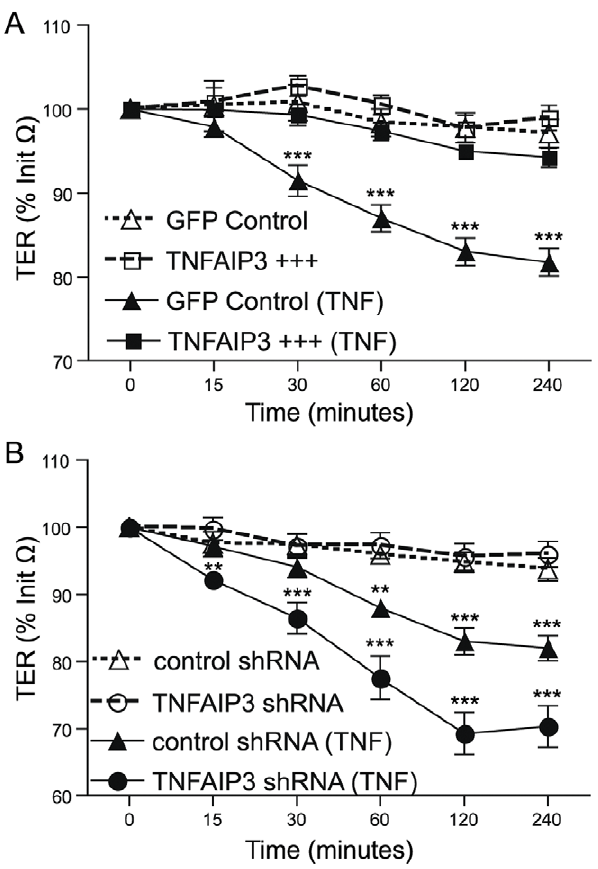
Figure 5. TNFAIP3 regulates TNF-induced tight junction dynamics in intestinal epithelial cells. Transepithelial electrical resistance (TER) was measured serially in cells grown in semi-permeable supports untreated (open symbols) or treated with TNF (10 ng/ml; closed symbols) for the indicated times. Values represent percentage of initial resistance measurements (% Init V ). Pools of cells were stably transduced with (A) GFP alone (GFP control; triangles) or GFP and TNFAIP3 (TNFAIP3 +++ ; squares); or (B) scrambled shRNA (control shRNA; triangles) or TNFAIP3 shRNA (circles). (**p , 0.01, ***p , 0.001; TNF-treated GFP controls vs. untreated GFP controls (A) or TNF-treated